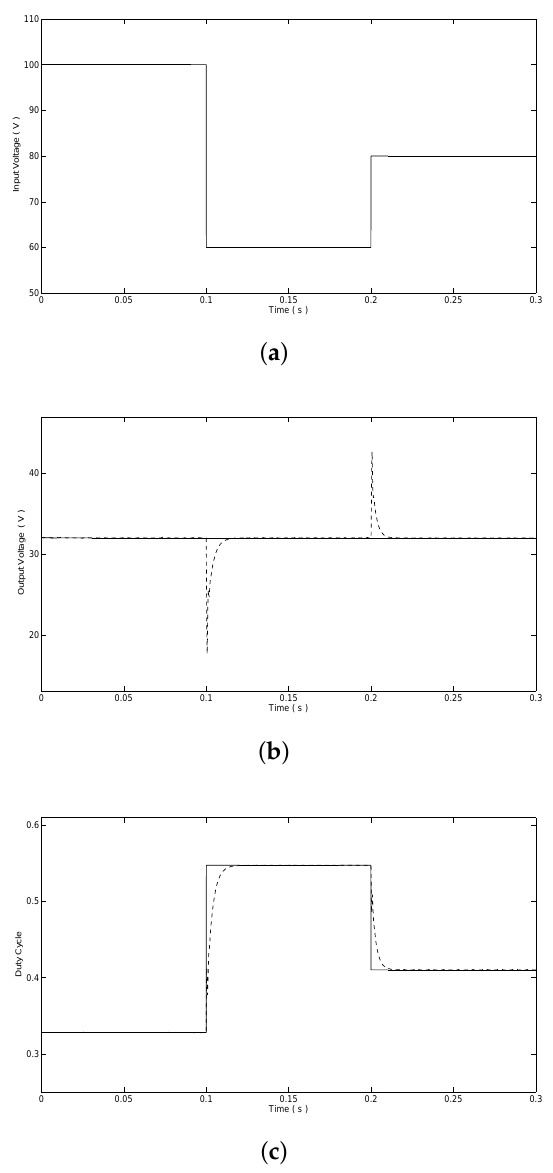
Figure 8. ( a ) The input voltage; ( b ) corresponding output voltage regulation; and ( c ) duty cycle input of DC-DC buck converter (proposed voltage regulation method ( ), PI cascade control ( −− )).